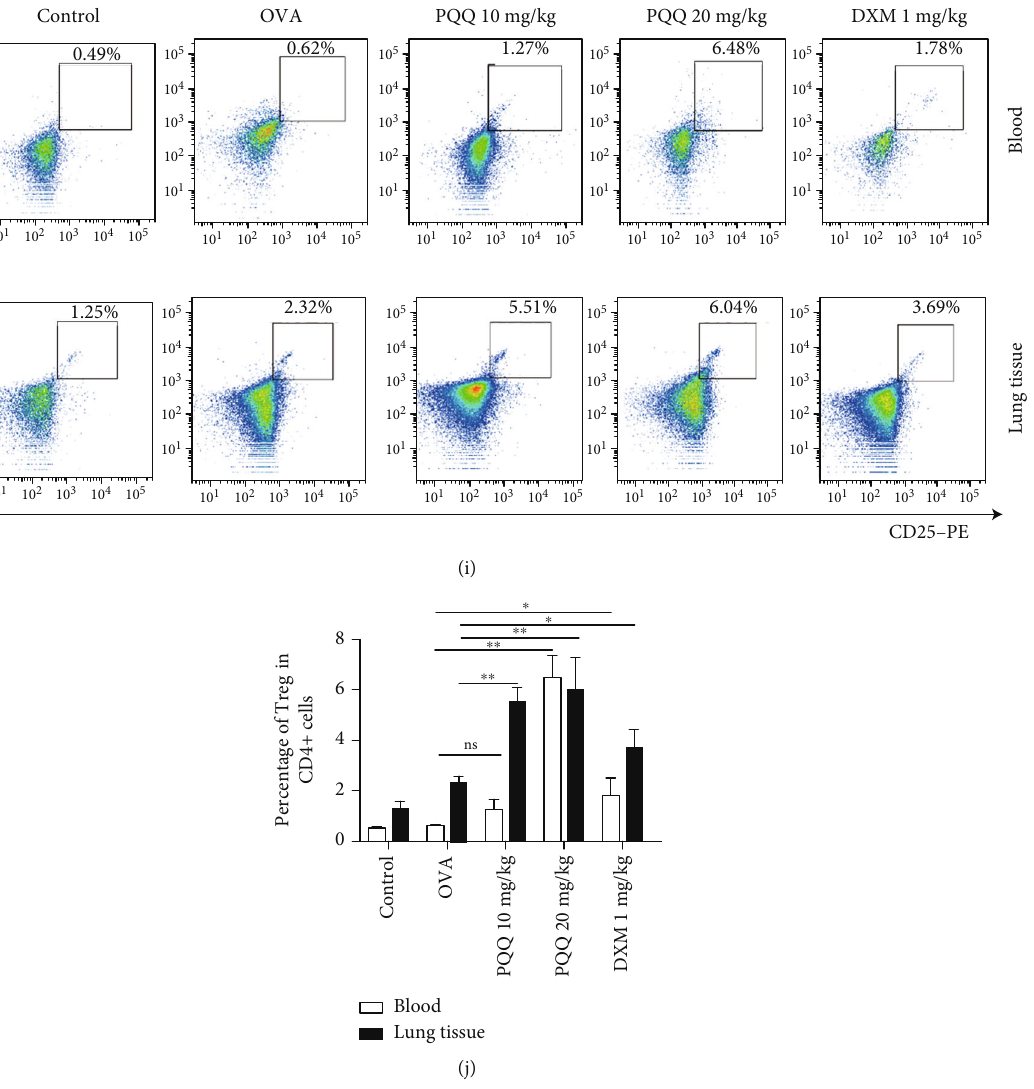
Figure 5: E ff ects of PQQ treatment on Th1, Th2, Th17, and Treg cells in peripheral blood and lung tissues of asthmatic model mice. (a and b) The gating strategy of fl ow cytometry for blood and tissue. (c and d) Representative scatter diagrams in fl ow cytometry and quantitative analysis of the percentages of CD4+IFN- γ +T cells in blood and lung tissues. (e and f) Representative scatter diagrams in fl ow cytometry and quantitative analysis of the percentages of CD4+ IL-4+ T cells in blood and lung tissues. (g and h) Representative scatter diagrams in fl ow cytometry and quantitative analysis of the percentages of CD4+ROR γ t+ T cells in blood and lung tissues. (i and j) Representative scatter diagrams in fl ow cytometry and quantitative analysis of the percentages of CD4+ CD25+FoxP3+ T cells in blood and lung tissues. The columns and error bars represent the means and SEMs ( n = 5 per group). ∗ P < 0 : 05 , ∗∗ P < 0 : 01 . Similar results were obtained in at least three independent 3.5. E ff ects of PQQ Treatment on Th1, Th2, Th17, and Treg